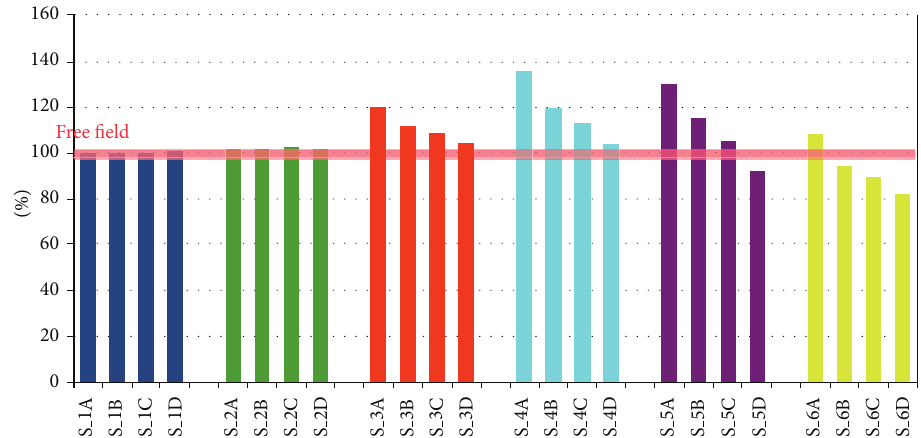
Figure 15: Peaks of the horizontal displacement of the control point 𝑂 , expressed in percent of the free-field peak